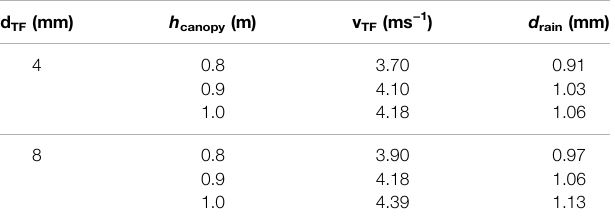
TABLE 2 | Throughfall droplet size corresponding in terms of kinetic energy with given rain drop size at terminal velocity. Variables shown are: Throughfall drop size ( d TF ), the maximum canopy height ( h canopy ) corresponding to the falling height of the throughfall droplet, the corresponding velocity of throughfall drop (v TF ), and equivalent rainfall drop diameter ( d rain ) with same kinetic energy at terminal